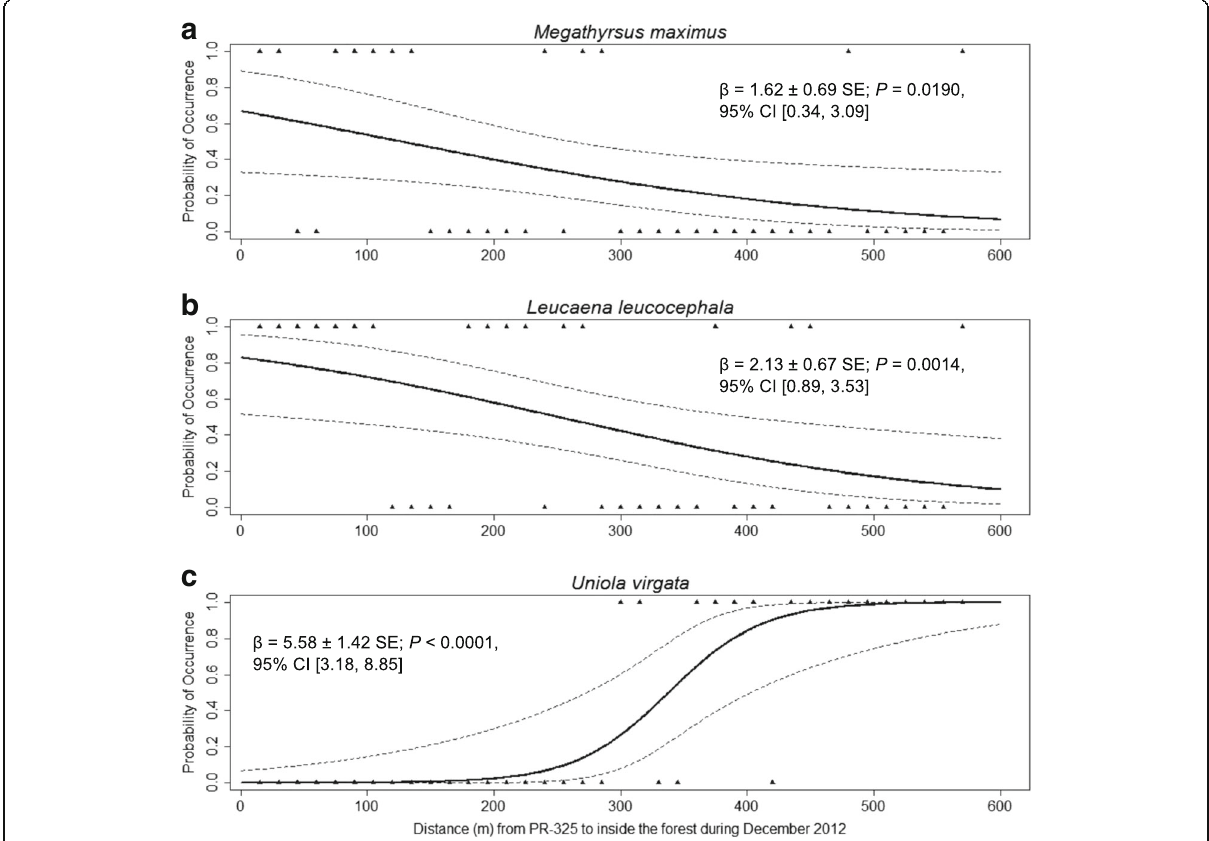
Fig. 3 The probability of occurrence ( ѱ ) for a Megathyrsus maximus , b Leucaena leucocephala , and c Uniola virgata , based on the seasonal model [ ѱ Time] from the roadside (0 m) to the power-line region inside the forest (600 m) for the December 2012